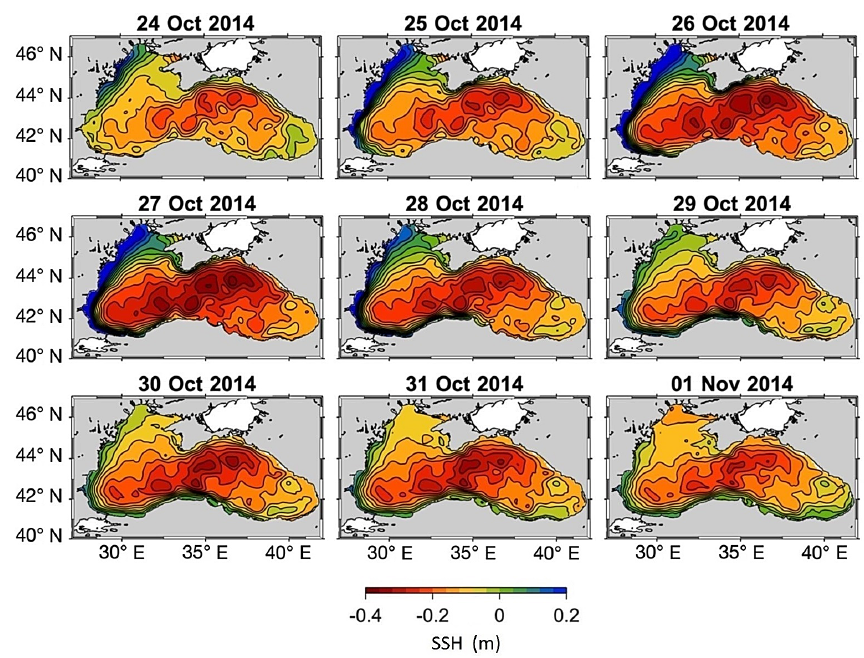
Figure 9. Sequence of daily mean sea surface height (SSH) distributions from 24 October to 1 November 2014, obtained from the Black Sea reanalysis product of